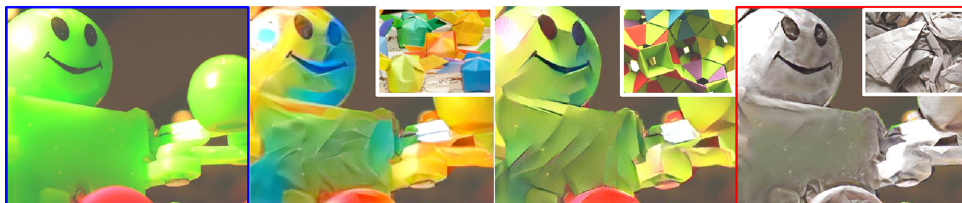
Figure 2. Examples of material translation (plastic → paper) using different style images (right corner of each generated result). The first picture shows the content image (blue), and the last is the generated image using our proposed framework